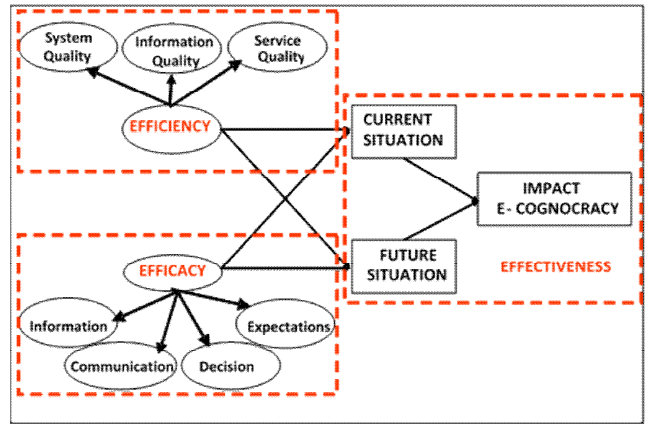
Figure 4. Theoretical EF3-framework for the Evaluation of e-Cognocracy (source: the authors).